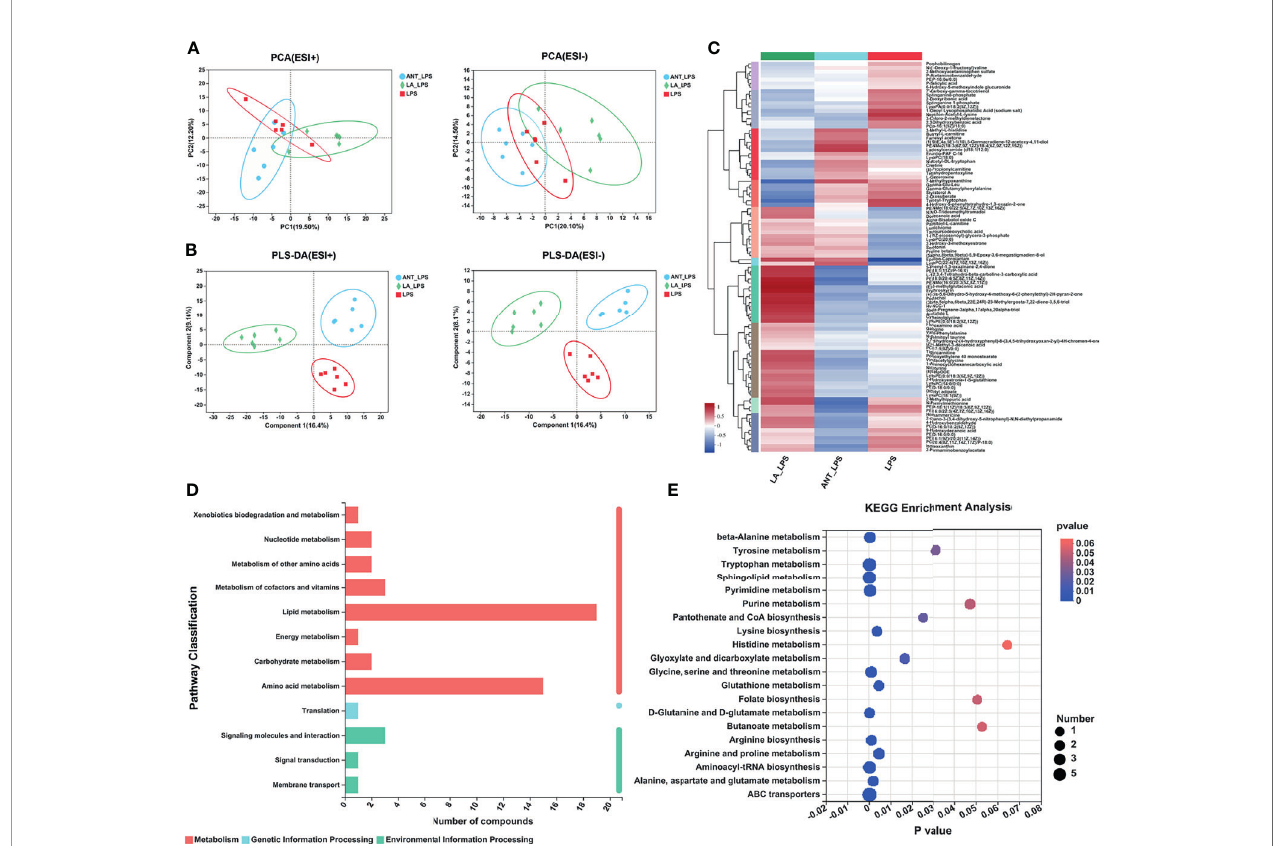
FIGURE 3 | Multivariate statistical analysis, hierarchical clustering and summary of Kyoto Encyclopedia of Genes and Genomes (KEGG) enrichment pathways. LPS: fed with a basal diet and injected with 0.5 mg/kg LPS; ANT+LPS: fed with a basal diet supplemented with 75 mg/kg ANT, and injected with 0.5 mg/kg LPS; LA+LPS: fed with a basal diet supplemented with 1000 mg/kg LA, and injected with 0.5 mg/kg LPS. N=6 in each group. (A) Principal component analysis (PCA) score plot of nontargeted metabolite pro fi ling of the serum samples among the three groups in both positive (ESI+) and negative ionization modes (ESI-). (B) Partial least squares-discriminant analysis (PLS-DA) score plot of metabolite pro fi ling among groups in ESI+ and ESI-. (C) Hierarchical clustering analysis of serum metabolites from the LPS, ANT+LPS and LA+LPS groups. (D) KEGG pathway classi fi cation. The compounds were enriched and numbered at the second KEGG level. (E) Bubble diagram showing the KEGG enrichment analysis. The bubble size indicates enriched the numbers, while the color shade indicates the